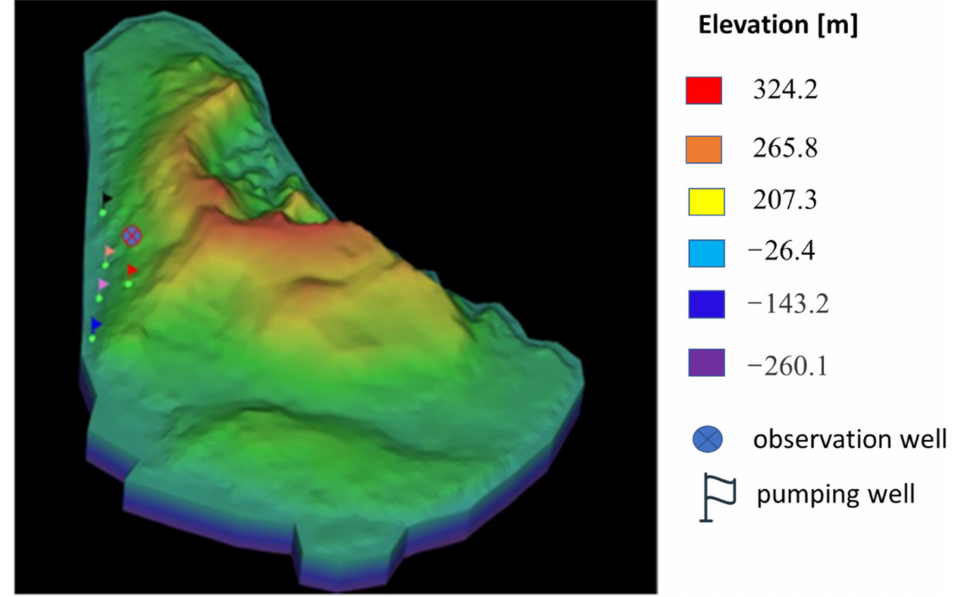
Figure 5. Map showing a 3D representation of the model domain with the location of pumping and observation wells used for the surrogate